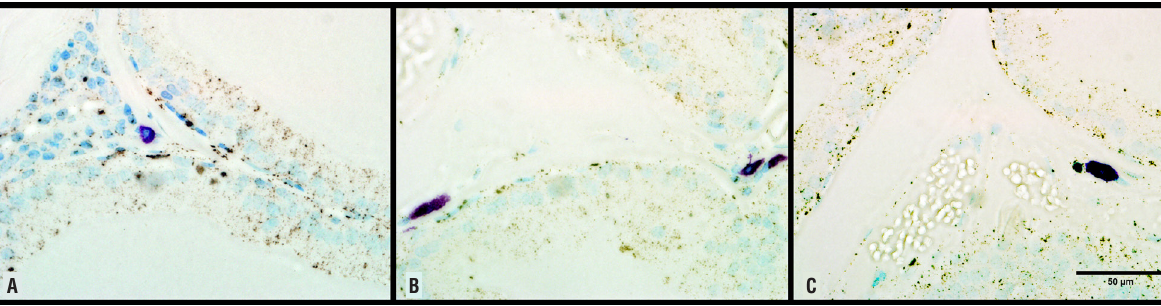
Figure 2 - Ventral prostate of rats immunolabeled with anti α -actin antibodies and observed under fluorescence microscopy under 400X magnification. In image A) we observe normal quantity of smooth muscle of Sham group. In image B) (group Orch) we observe an increase of muscle fibers, which returned to normal in image C) (group Orch+T).